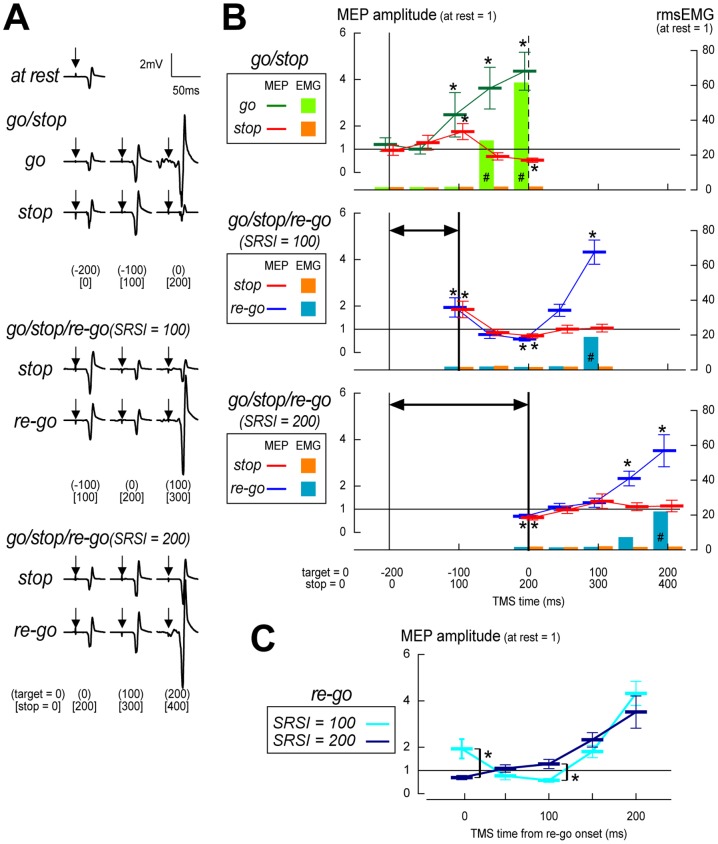
Results of motor evoked potential analyses in Experiment 2.(A) Raw motor evoked potential (MEP) waveforms for a typical subject (top: at rest; second from the top: go/stop task; third from the top: go/stop/re-go task with a stop-to-restart interval (SRSI) of 100 ms; bottom: go/stop/re-go task with an SRSI of 200 ms). Trial type is labeled on the right side of the EMG trace. Time point at which transcranial magnetic stimulation was delivered (TMS time) is shown in round bracket (relative to the target) and in square bracket (after stop-signal onset) on the bottom. Arrows on the electromyogram (EMG) traces indicate artifacts from the TMS pulses. (B) Group means (±SD) of standardized MEP amplitudes and root-mean-square EMGs (rmsEMGs) (top: go/stop task; middle: go/stop/re-go task with an SRSI of 100 ms; bottom: go/stop/re-go task with an SRSI of 200 ms). Two time scales are displayed at the bottom. Vertical dashed lines at 0 ms in the top panel represent the time point of the target for the primary go task. Vertical thin lines at –200 ms in all three panels represent the time point at which the indicator stopped. Vertical thick lines at –100 ms in the middle panel and at 0 ms in the bottom panel represent time points when the indicator restarted. Two-headed arrows in the middle and bottom panels represent SRSIs in milliseconds. TMS times refer to the time that TMS was delivered relative to the target (top) and after stop-signal onset (bottom). * p<.05; significant difference in planned comparisons between MEP amplitudes at each TMS time and baseline (at rest). # p<.05; significant difference in planned comparisons between rmsEMGs at each TMS time and baseline (at rest). (C) Group mean (±SD) of MEP amplitudes in re-go trials, rearranged according to TMS time relative to re-go-signal onset. * p<.05; significant difference in planned comparisons between MEP amplitudes in re-go trials with an SRSI of 100 ms and 200 ms for each TMS time.